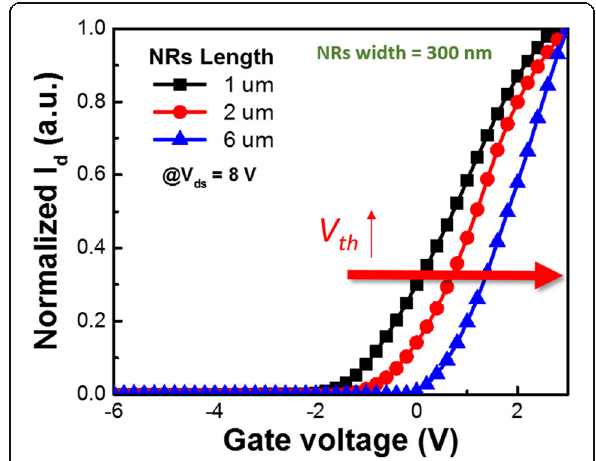
Fig. 4 I DS – V G transfer characteristics of devices having a fixed value of W MMC of 300 nm and various values of L MMC